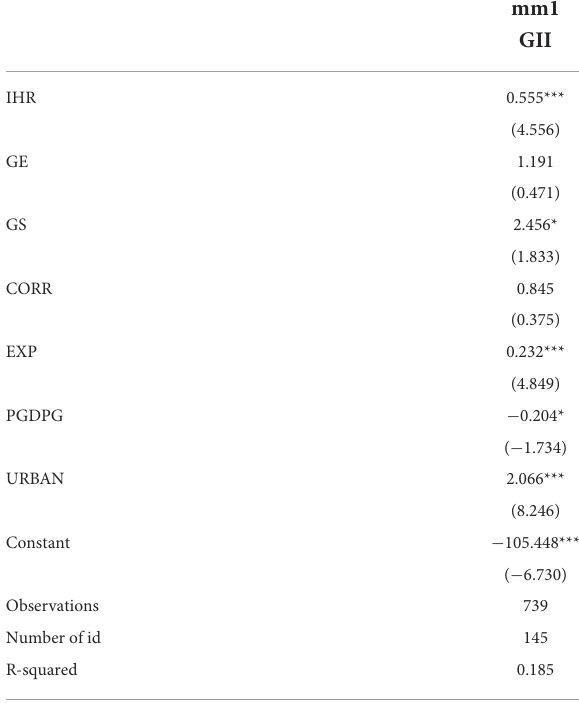
TABLE 6 Effect of public health policy quality on state innovation capacity with an alternative measurement.